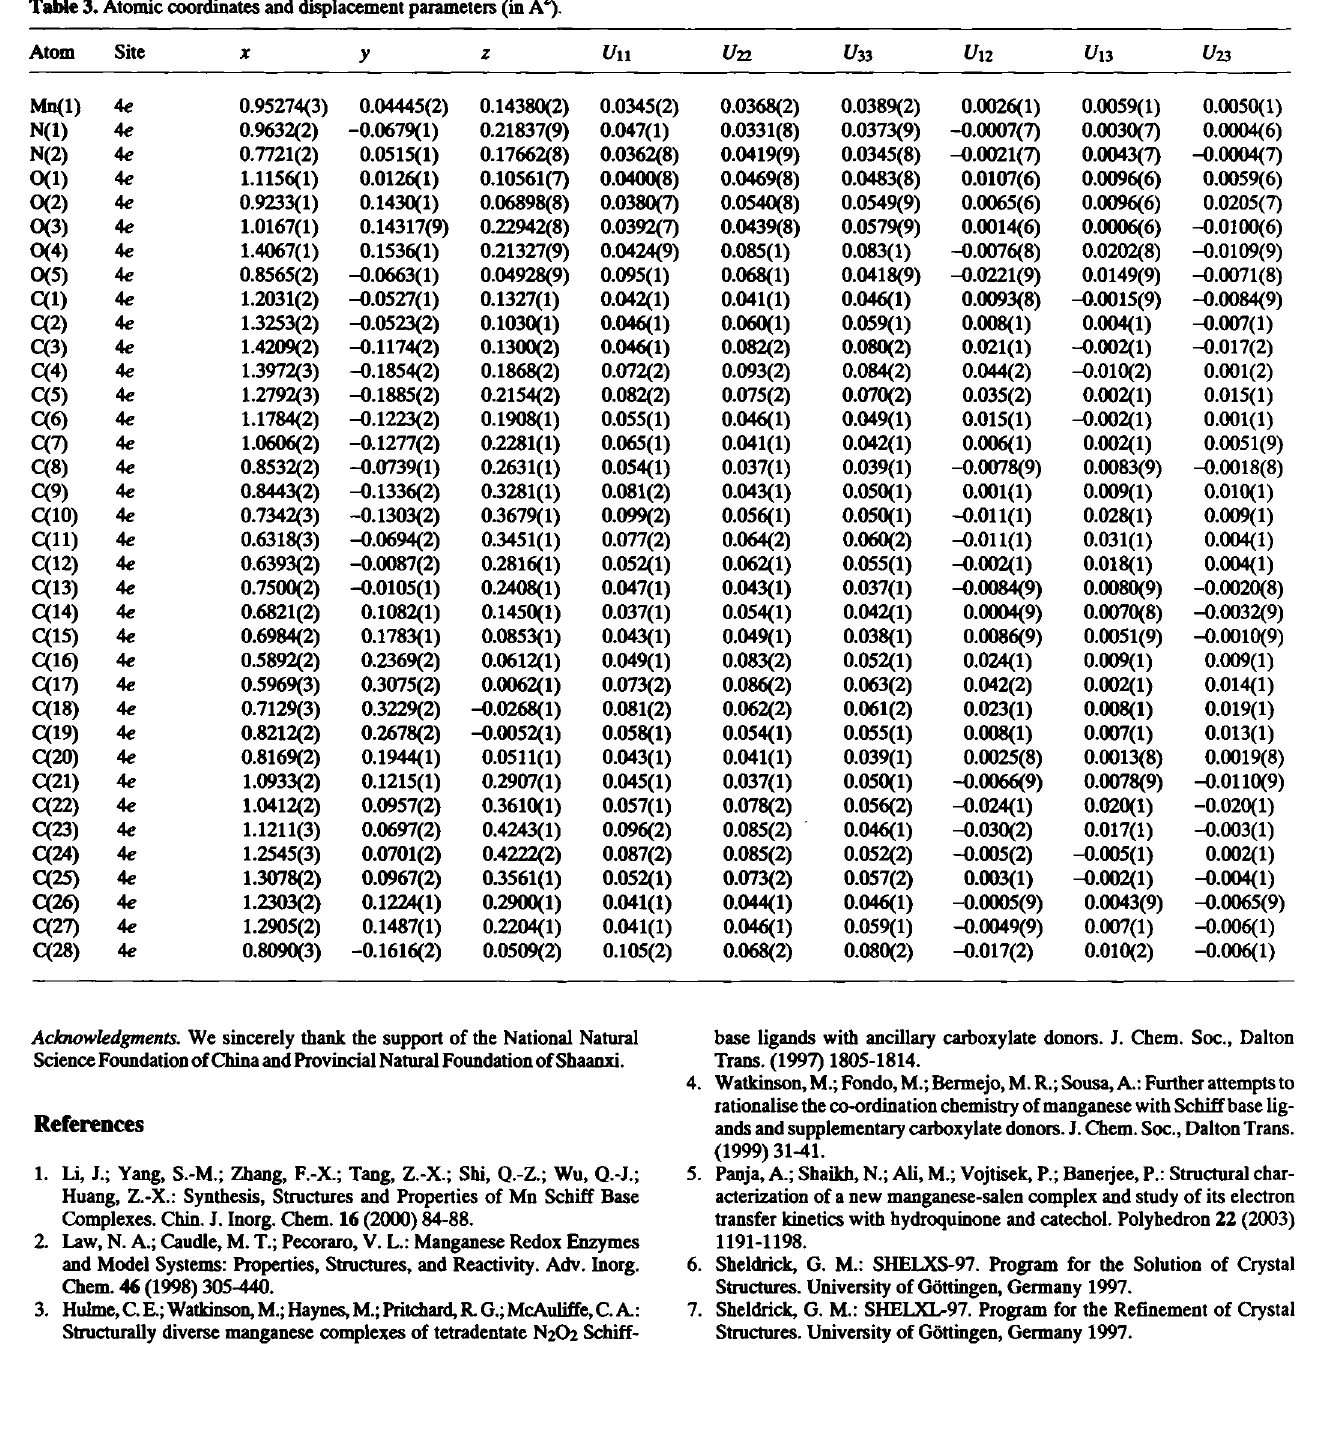
Table 3. Atomic coordinates and displacement parameters (in Ä 2